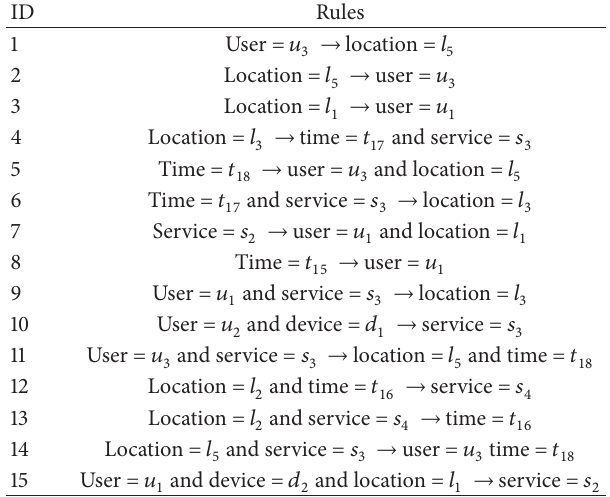
Table 8: The results based on GRI algorithm.